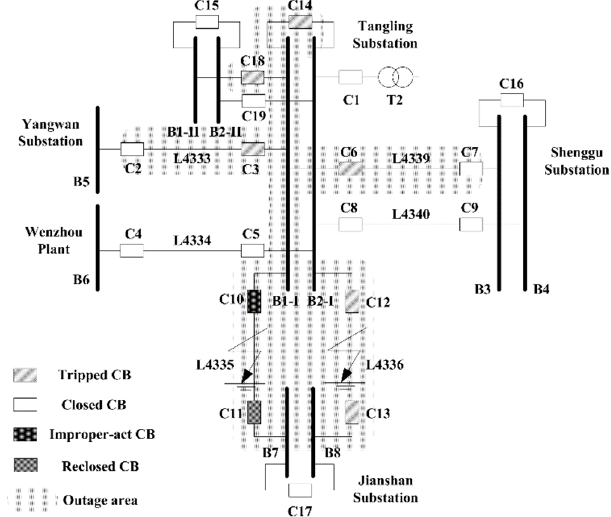
Figure 4. Part of the power network in Zhejiang province. Table 1. Received Alarm.